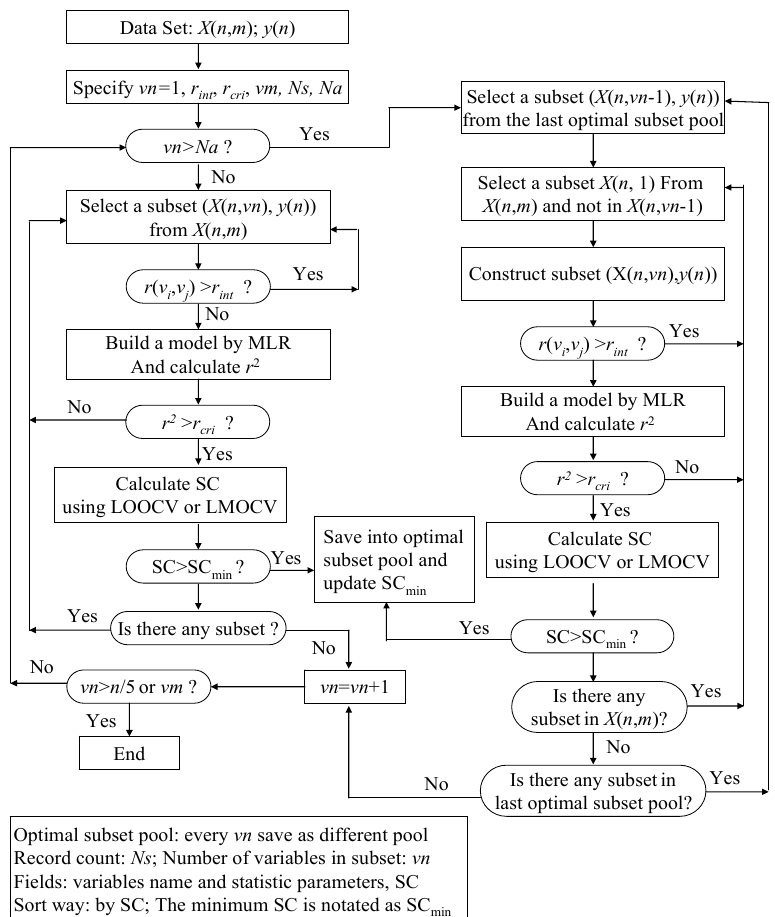
Figure 7. Variable selection method based on variables